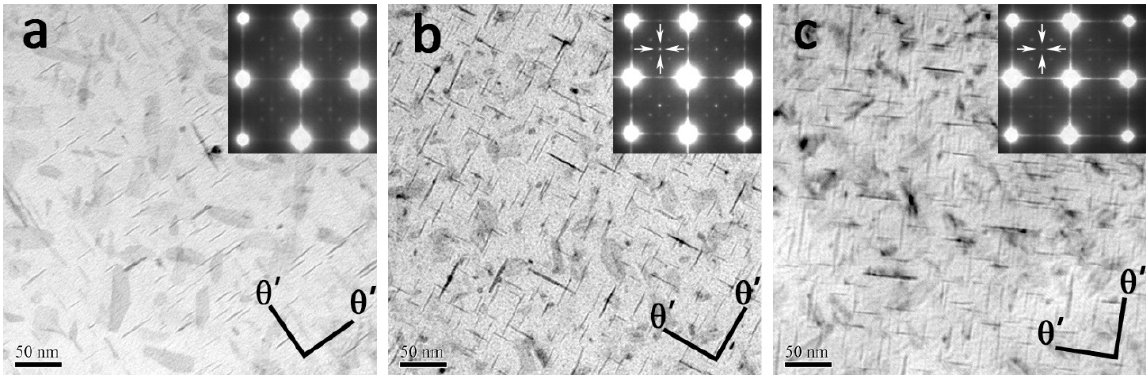
Figure 9. TEM images of studied alloys in T6 state and corresponding SAED patterns (near <100> α direction). ( a ) Er-free; ( b ) 0.09Er; ( c ) 0.20Er.